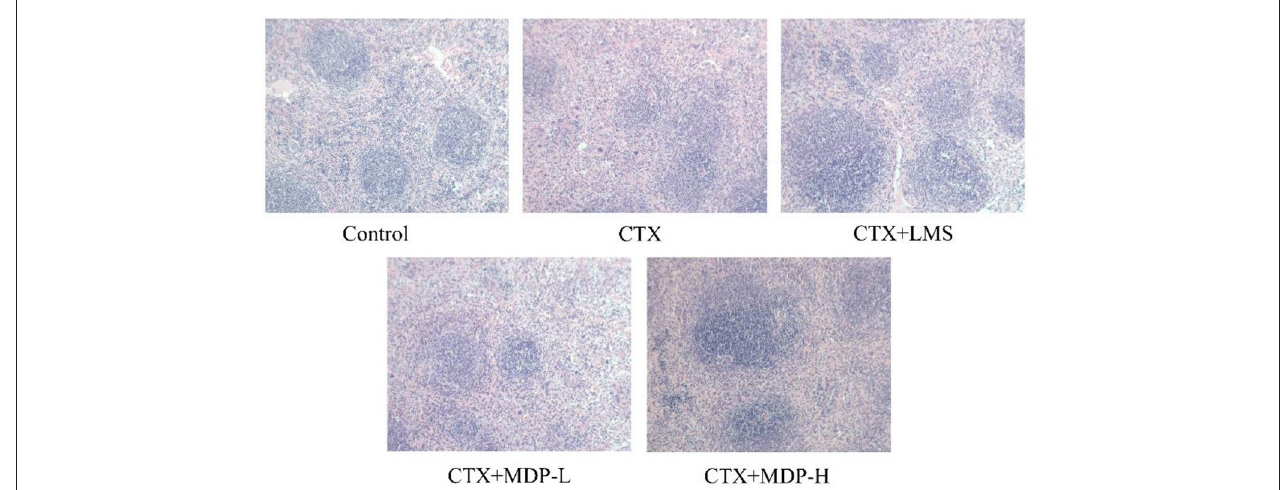
FIGURE 9 | Effect of MDP on the histological morphology of spleen in mice induced by CTX.